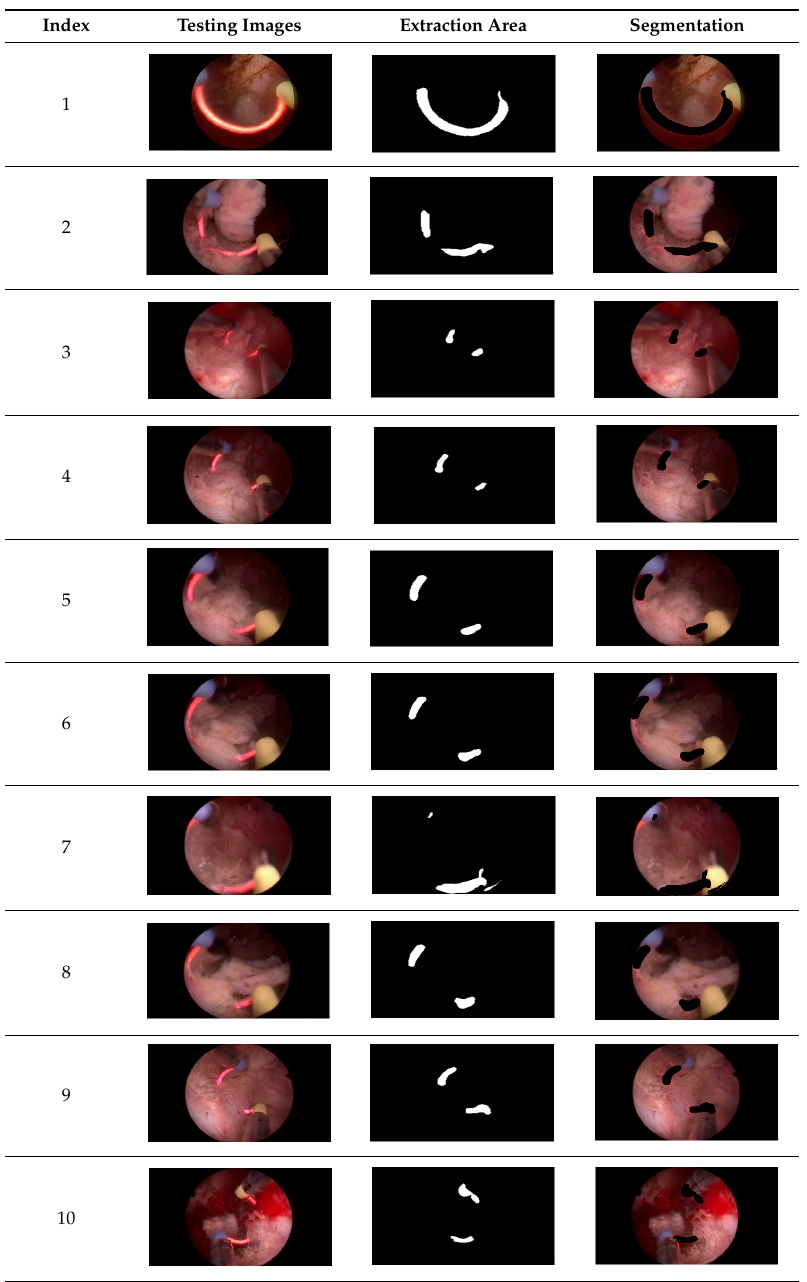
Table 8. Performance of segmenting the red light image using U-Net model.